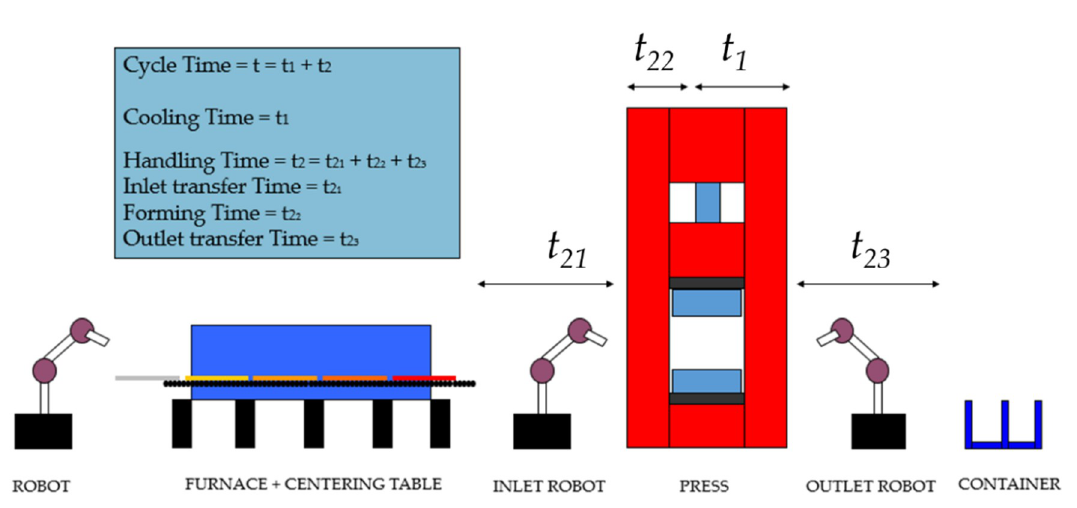
Figure 2. Scheme of a hot stamping line, where the cycle time components are defined.